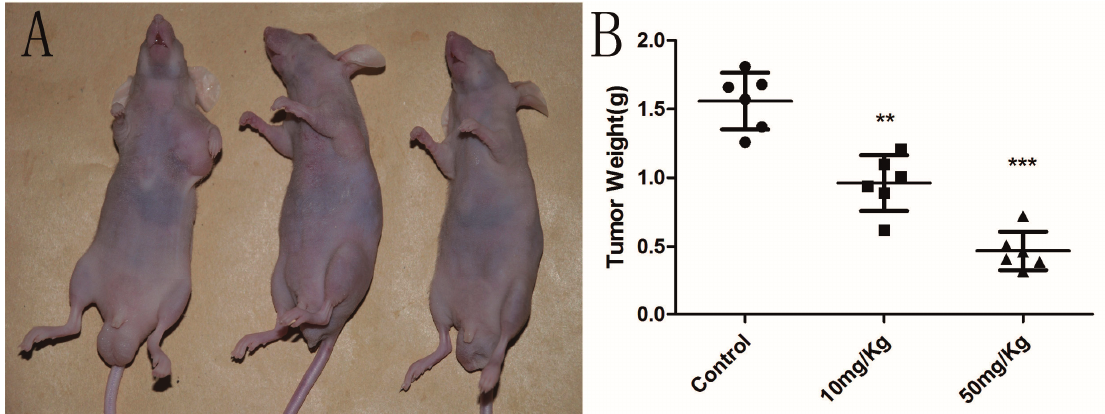
Figure 7. Cordycepin suppress tumor growth in vivo